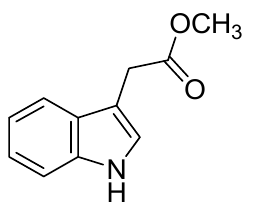
Figure 14. Methyl-3-indolyacetate (MIA).